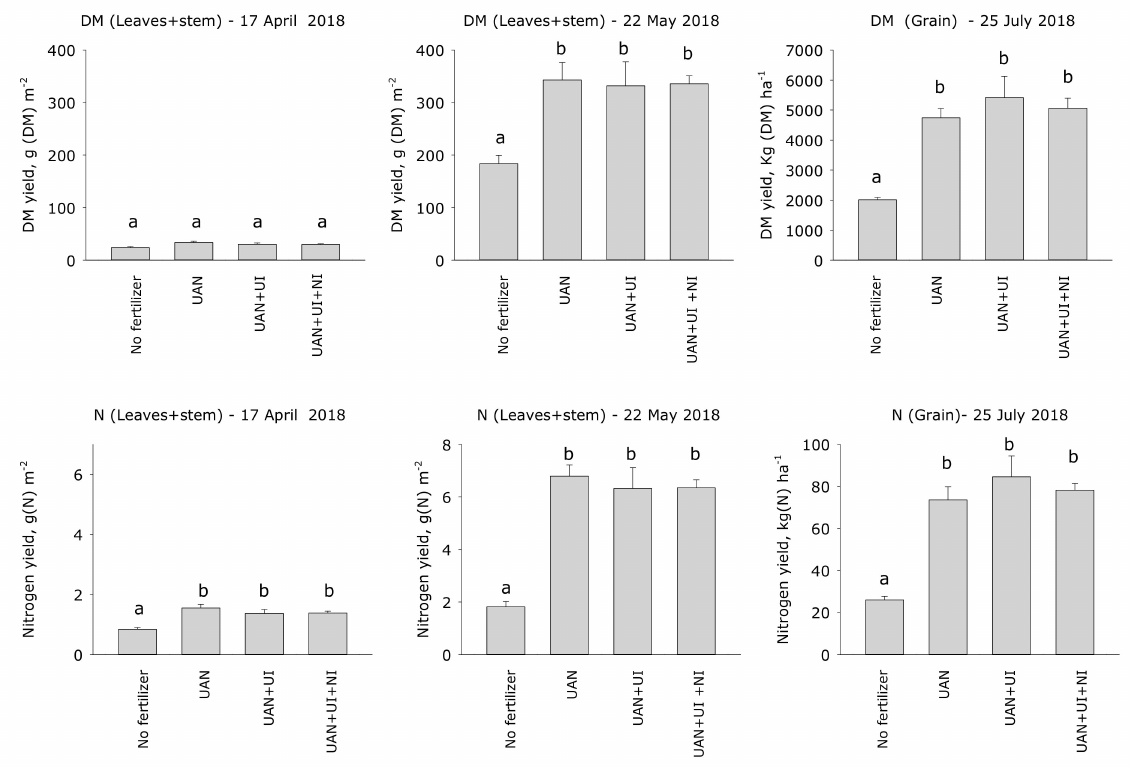
Figure 7. Winter wheat plant leaves and stem on 17 April and 22 May 2018 and harvested grain yield on 25 July 2018. Top dry matter yield and bottom N yield. The treatments were UAN; UAN without additives, UAN + UI; UAN mixed with urease inhibitor (UI) or UAN + UI + NI; UAN mixed with UI and nitrification inhibitor (NI) (Error bars: SE, n =